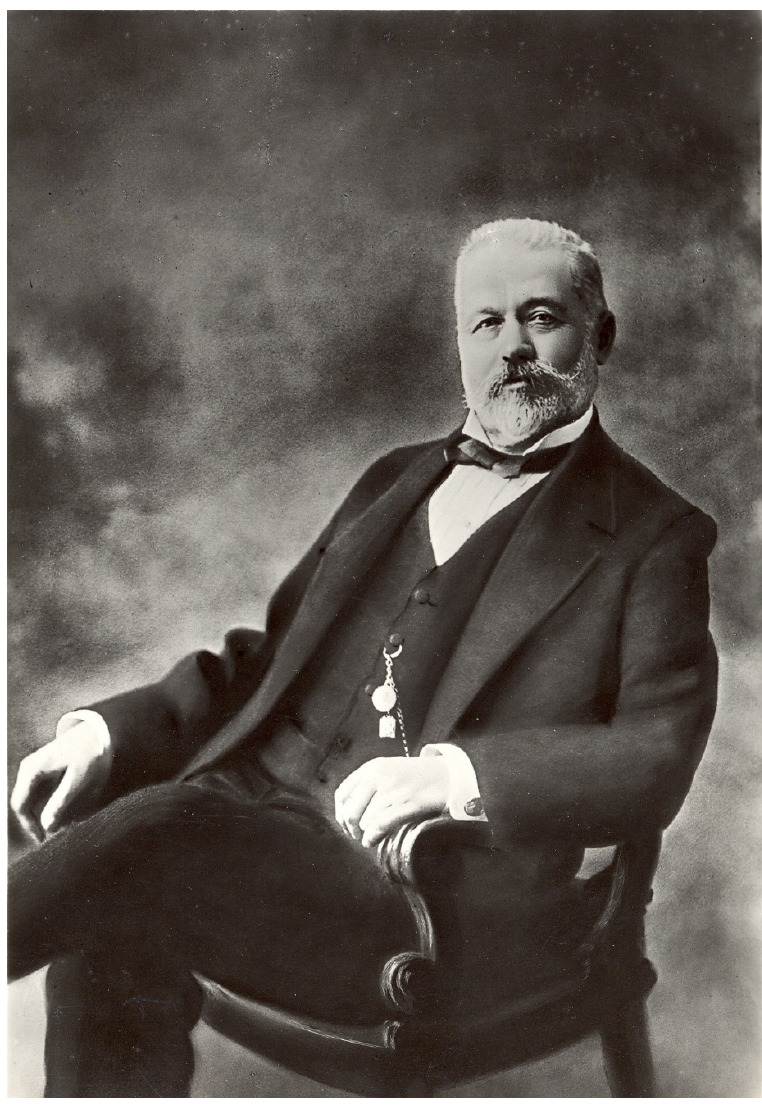
Figure 5. Carlo Forlanini in the last years of his life. Museum for the History of the University of Pavia.